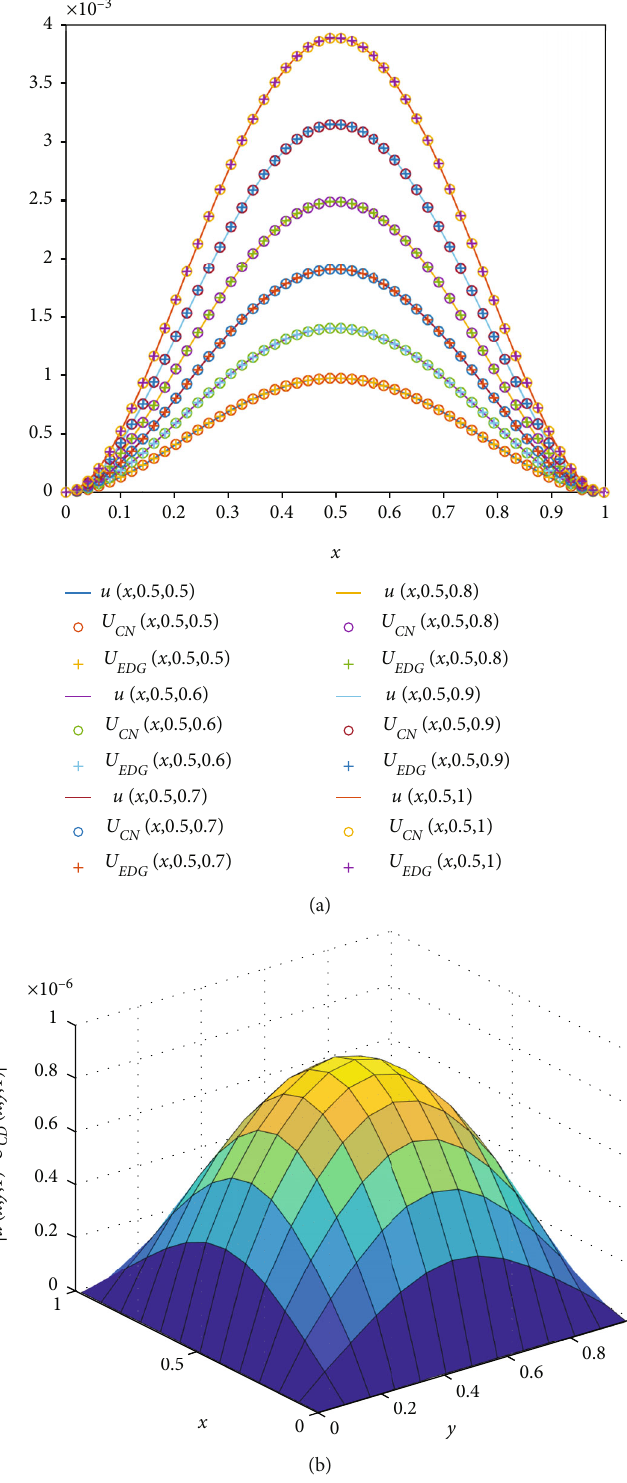
Figure 7: The exact, Crank – Nicolson and EDG solutions in di ff erent values of t (a) and the absolute error of Crank – Nicolson method at T = 1 (b) of Example 16 for Δ t = 0 : 01 , Re = 60 , N = 49 , and α = 0 : 5